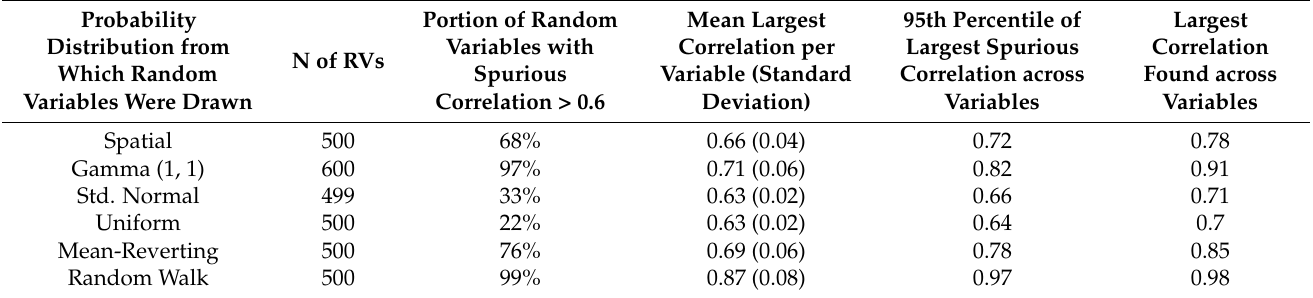
Table 3. Frequency of spurious correlations identified by Google Correlate by distribution of random